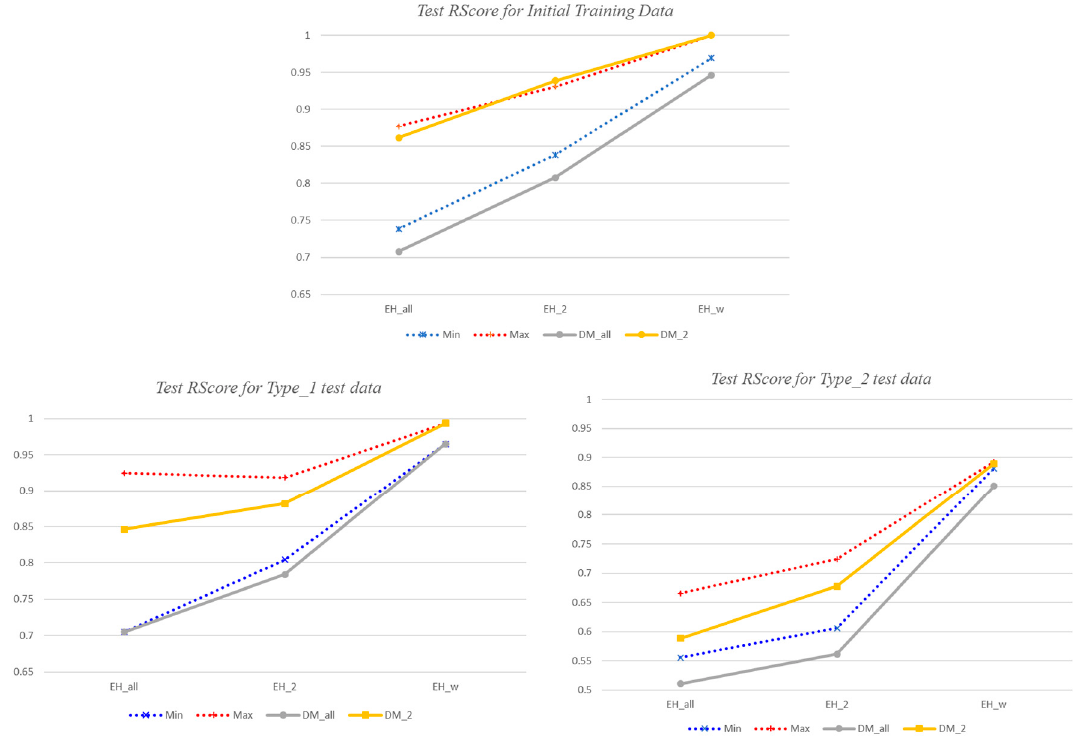
Figure 12. RScore of the enhanced models for the initial training data and test data.